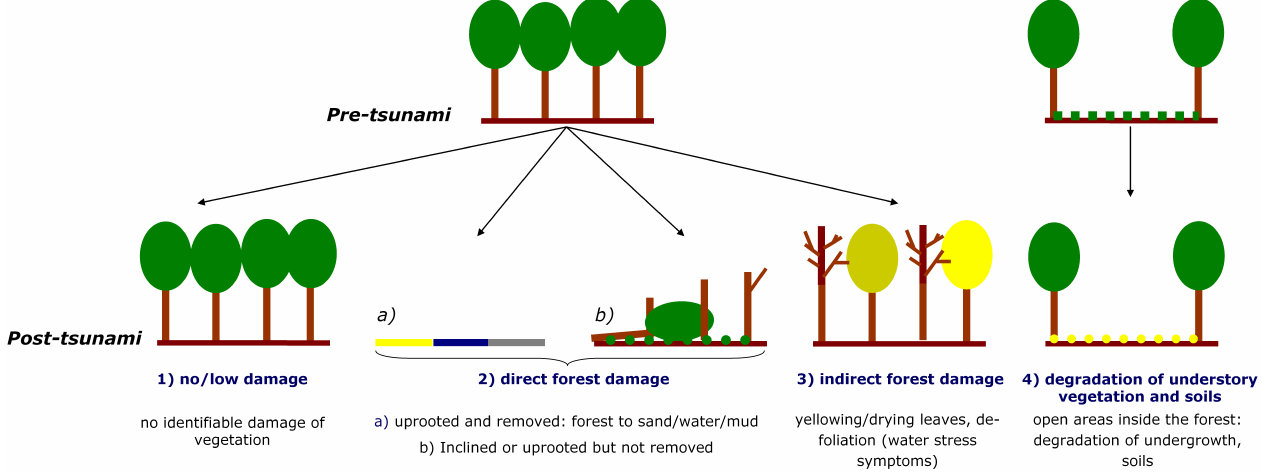
Table 2. Training and test area for DMC. Change Classes (ID / name) 1